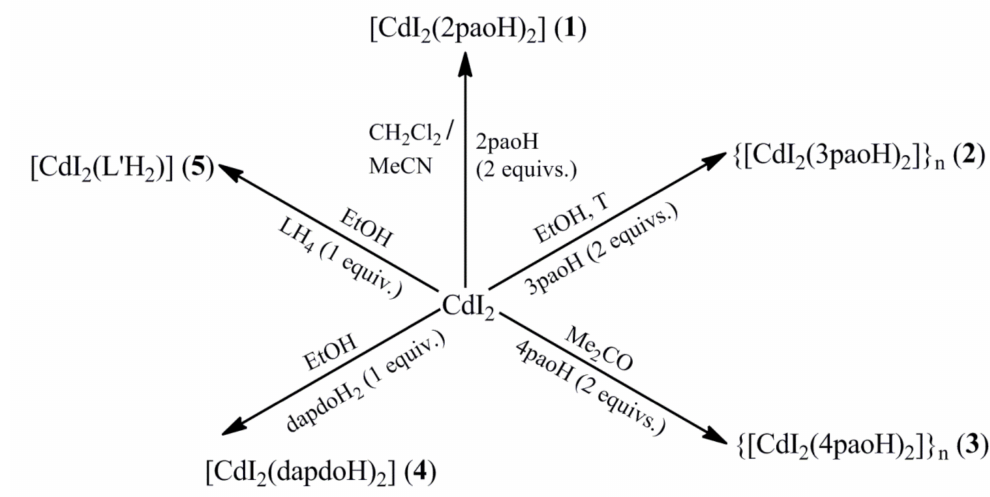
Figure 2. Optimized experimental reaction conditions that lead to Cd(II) complexes ( 1 – 5 ); the lattice EtOH molecules in the dapdoH 2 complex are not shown. The structural formula of the ligand L (cid:48) H